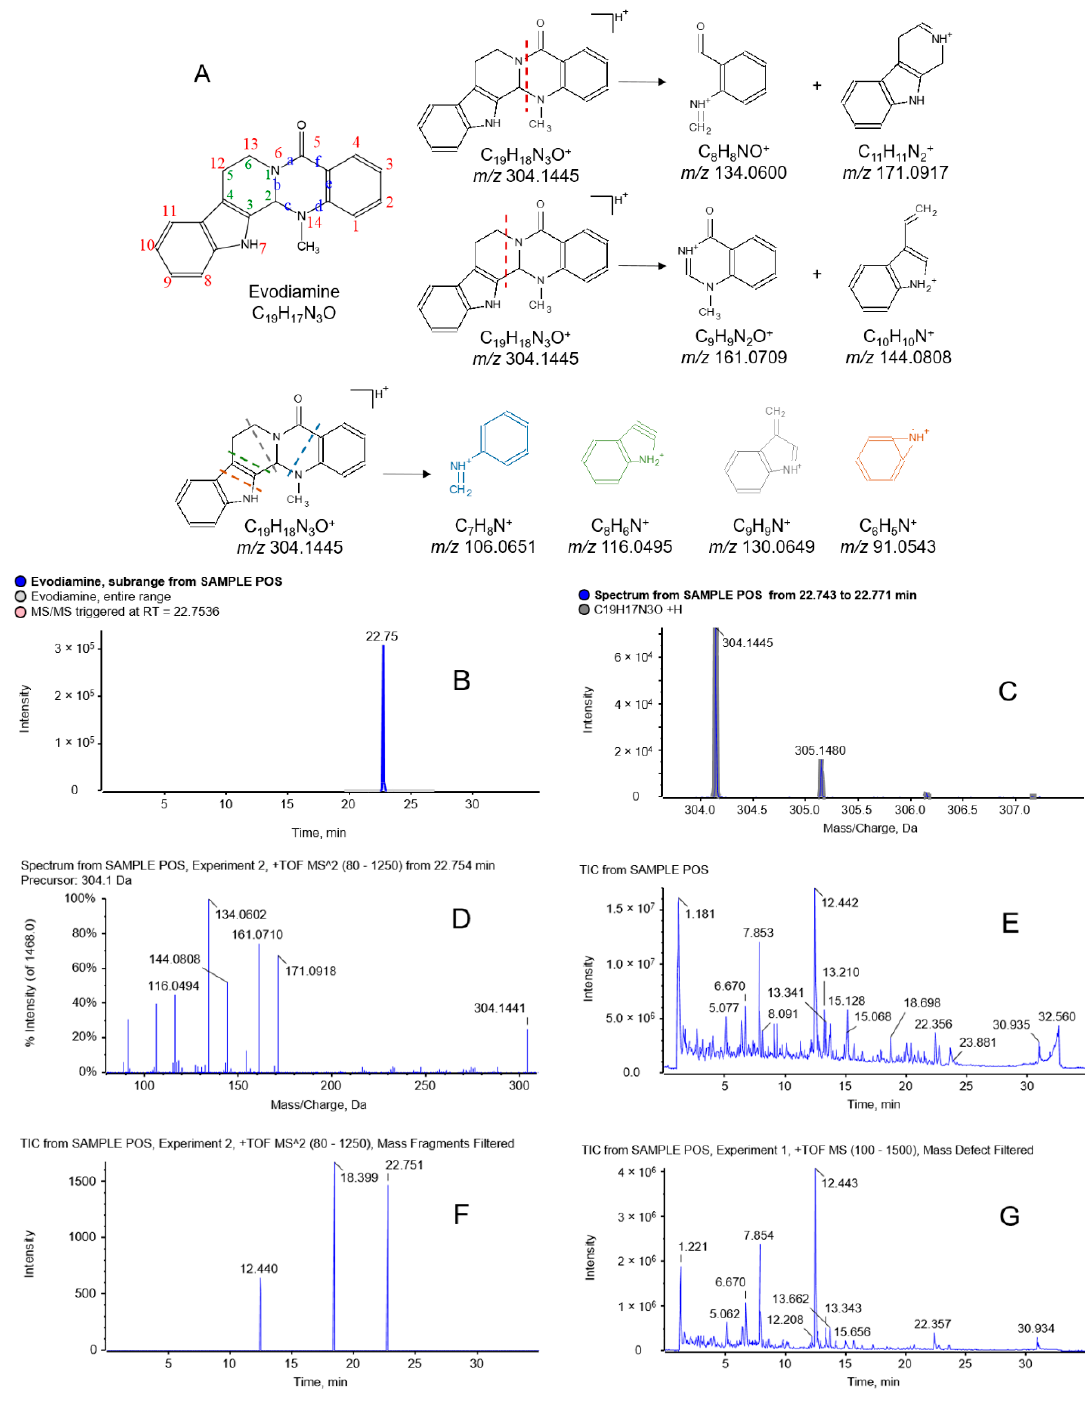
Figure 2. Fragmentation pattern of evodiamine and its analogous alkaloids. ( A ) Structure and fragmentation pathways of evodiamine, ( B ) XIC of evodiamine, ( C ) precursor ion TOF MS spectrum of evodiamine, ( D ) product ion MS/MS spectrum of evodiamine, ( E ) TIC of TOF MS scan of WZYD in positive ion mode, ( F ) TIC of CID experiment 2 after fragment filtering, and ( G ) TIC of TOF MS scan after MDF.